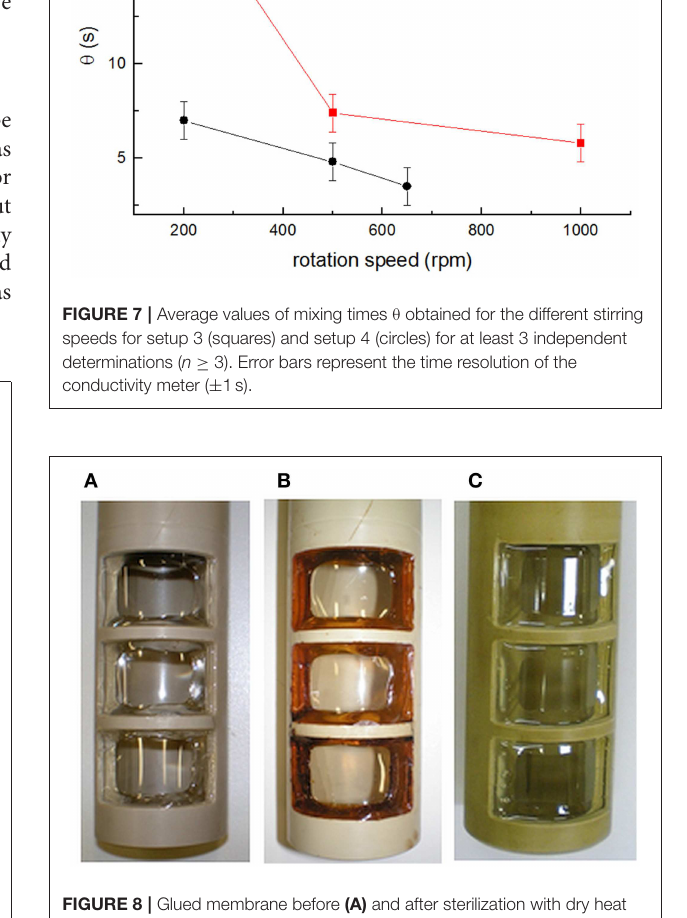
Frontiers in Energy Research |